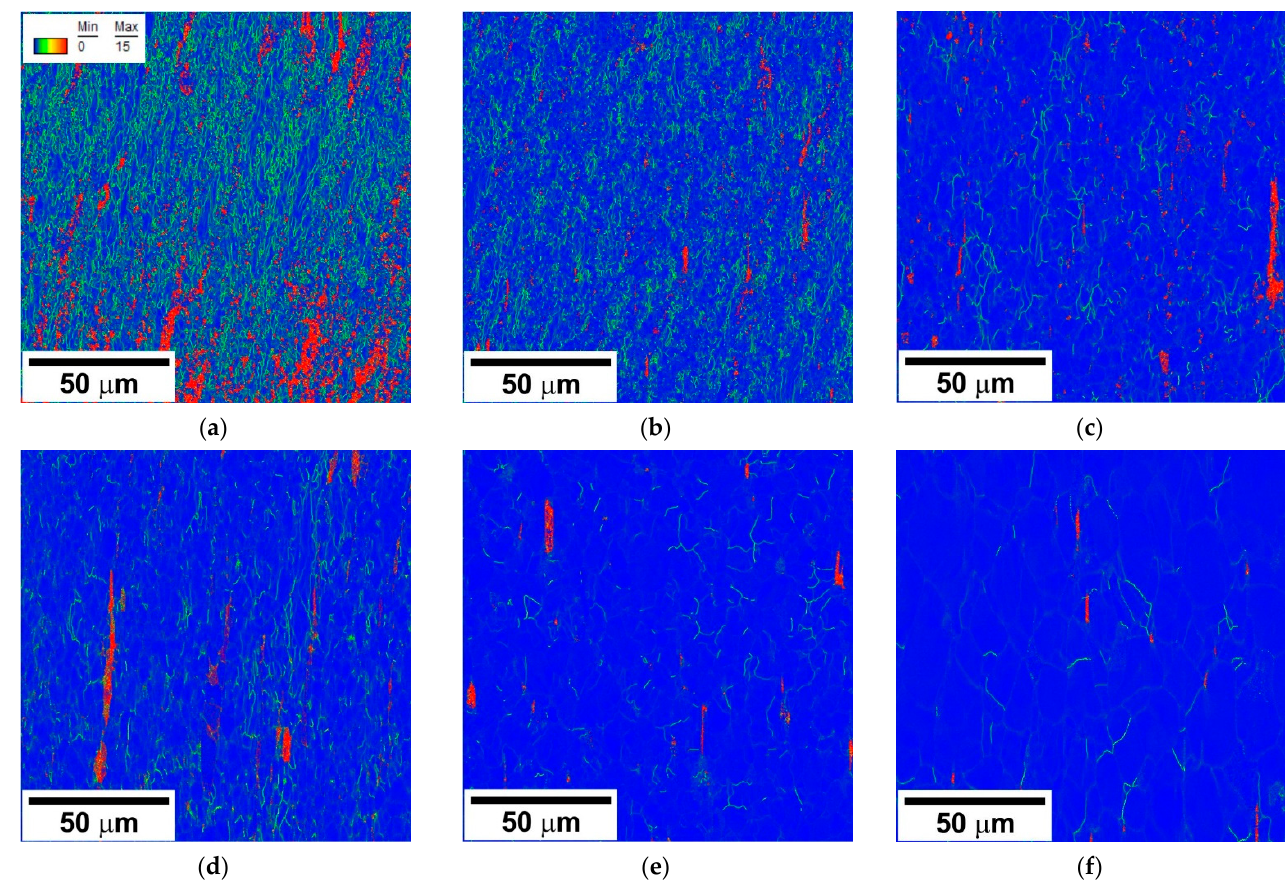
Figure 6. Kernel average misorientations in a highly-alloyed austenitic stainless steel subjected to hot compression at 800 °C, 10 − 2 s − 1 ( a ) 900 °C, 10 − 2 s − 1 ( b ), 900 °C, 10 − 4 s − 1 ( c ), 1000 °C, 10 − 2 s − 1 ( d ), 1000 °C, 10 − 4 s − 1 ( e ), and 1100 °C 10 − 4 s − 1 ( f ).